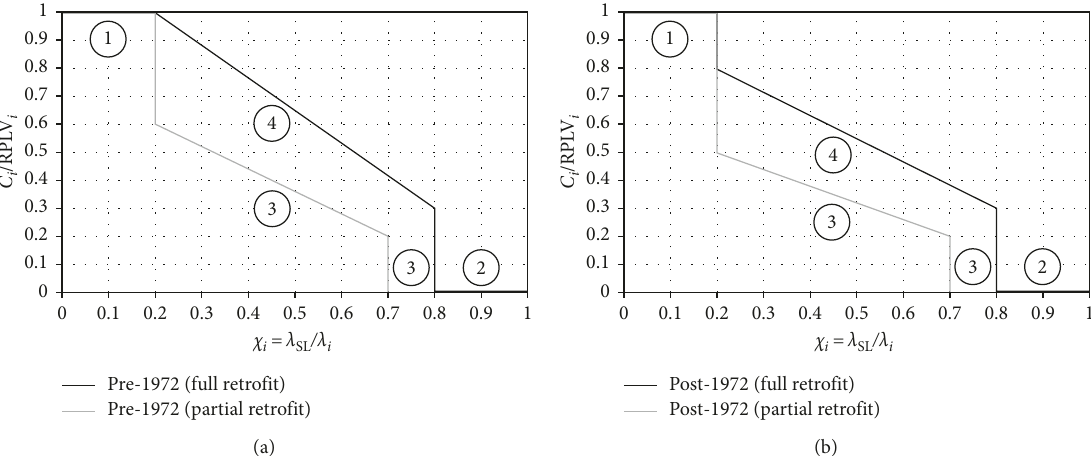
Figure 1: Estimation of retrofitting cost based on the risk level of two classes of buildings for “partial” and “full” retrofitting: (a) buildings constructed before 1972; (b) buildings constructed after